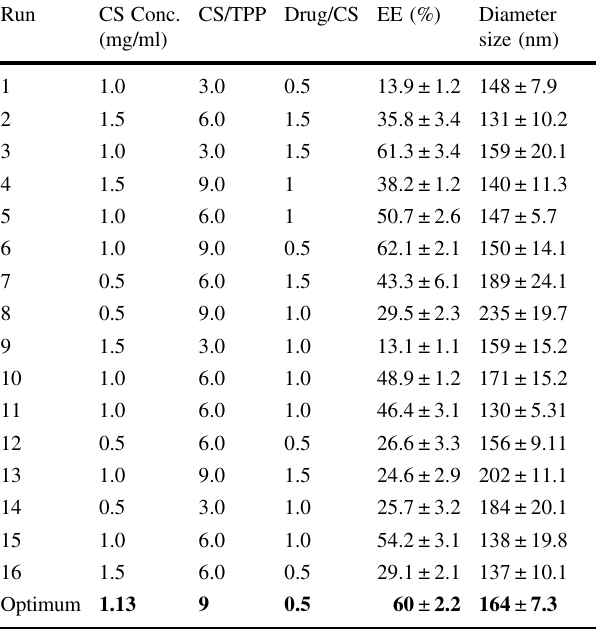
Table 2 Box – Behnken design matrix with three independent variables at three levels and the observed